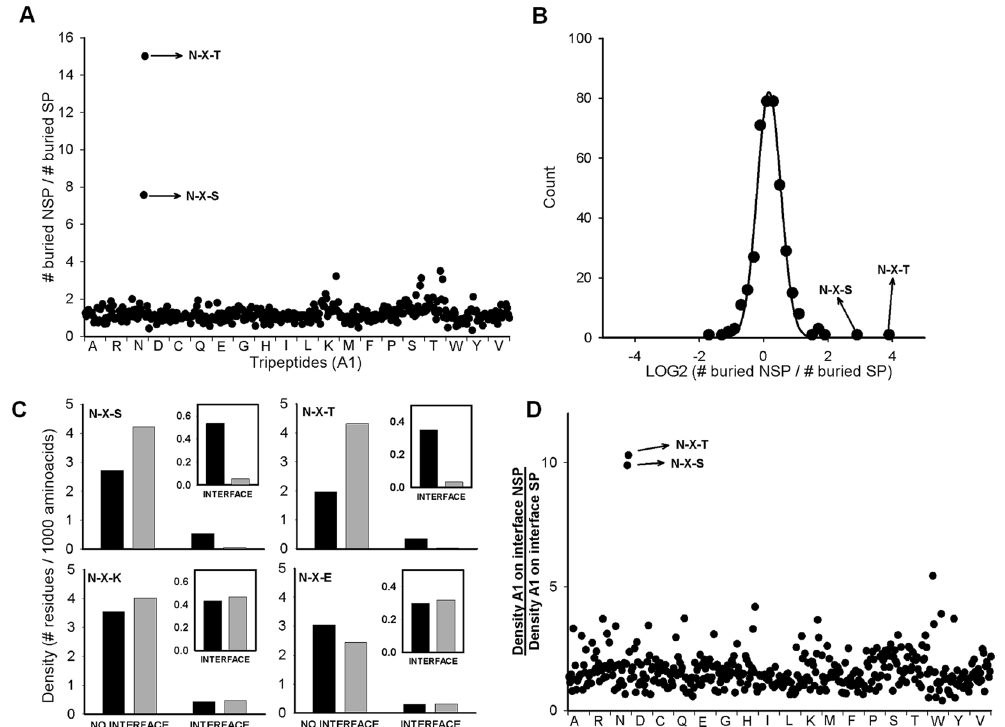
Figure 4. Sequence characteristics of buried residues in secretory and non-secretory pathway proteins. ( A ) Ratio of the number of buried A1 residues in A1-X-A3 tripeptides in NSP compared with SP proteins. Residue A1 of each tripeptide is shown in the x axis. ( B ) Log2 distribution of the ratios from panel A. A Gaussian curve was fitted to the data. ( C ) Frequency of exposed Asn in the indicated tripeptides located at protein-protein interfaces or elsewhere on protein surfaces. NSP and SP proteins are in black and gray, respectively. A total of 1,209,862 and 147,995 residues were analyzed for NSP and SP protein complexes, respectively. Inset: zoom of density values for residues at the interface. ( D ) Ratio of A1 residue densities at interfaces of NSP compared with SP proteins for all A1-X-A3. In panels A and D each dot represents one of the 400 possible tripeptides arranged in alphabetic order (Ala-X-Ala, Ala-X-Arg, … ,